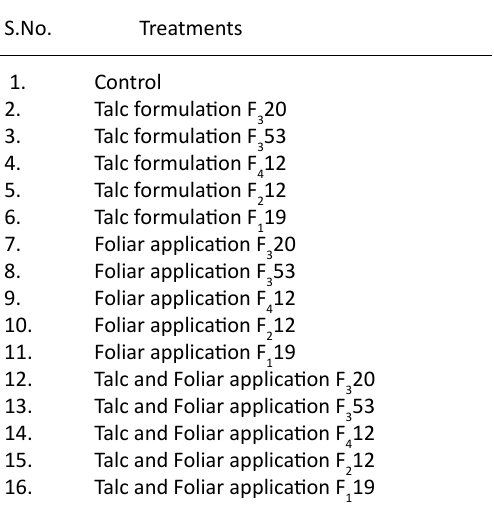
Table 1. Treatment involved in field trails. S.No.